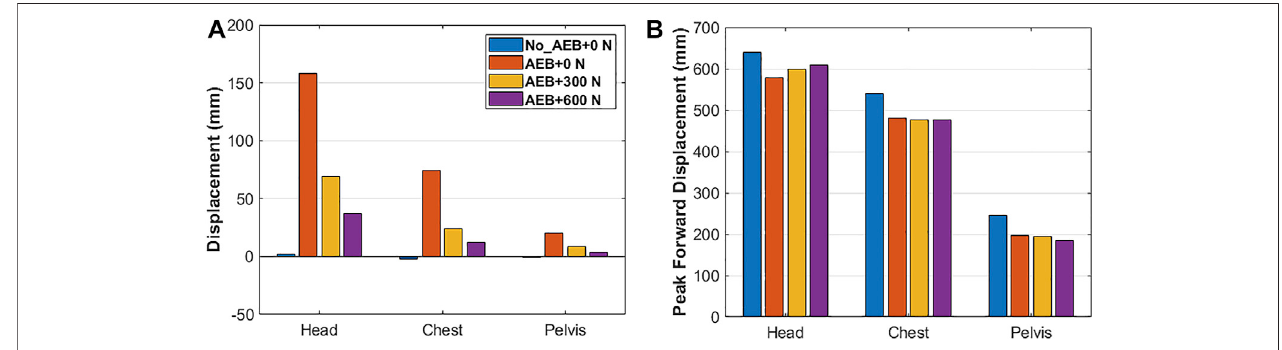
FIGURE 3 | Head, chest, and pelvis forward displacements: (A) at the beginning of crash phase and (B) peak values in crash phase. Note: Y-axis scales differ.